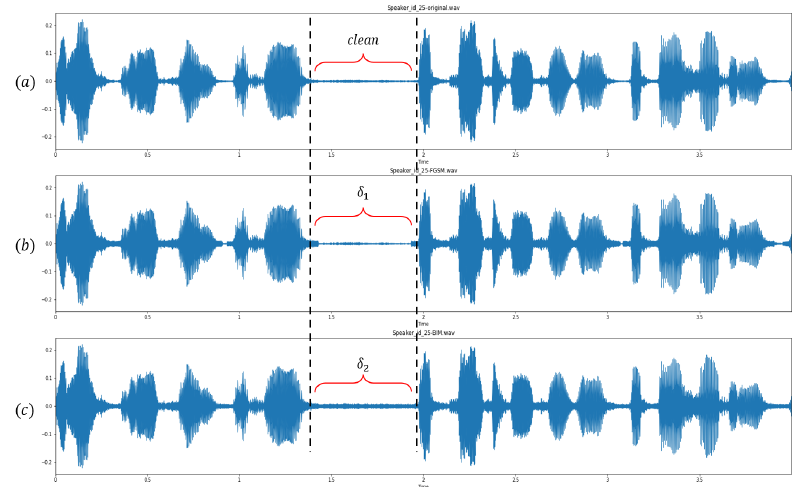
Figure 7. A example of the waveforms of original audios and adversarial audios generated by FGSM- and BIM-based time-domain perturbations. Figure ( a ) shows the waveform of the original audio, while figure ( b , c ) show the waveforms of the adversarial audio generated by the FGSM and BIM algorithms respectively.